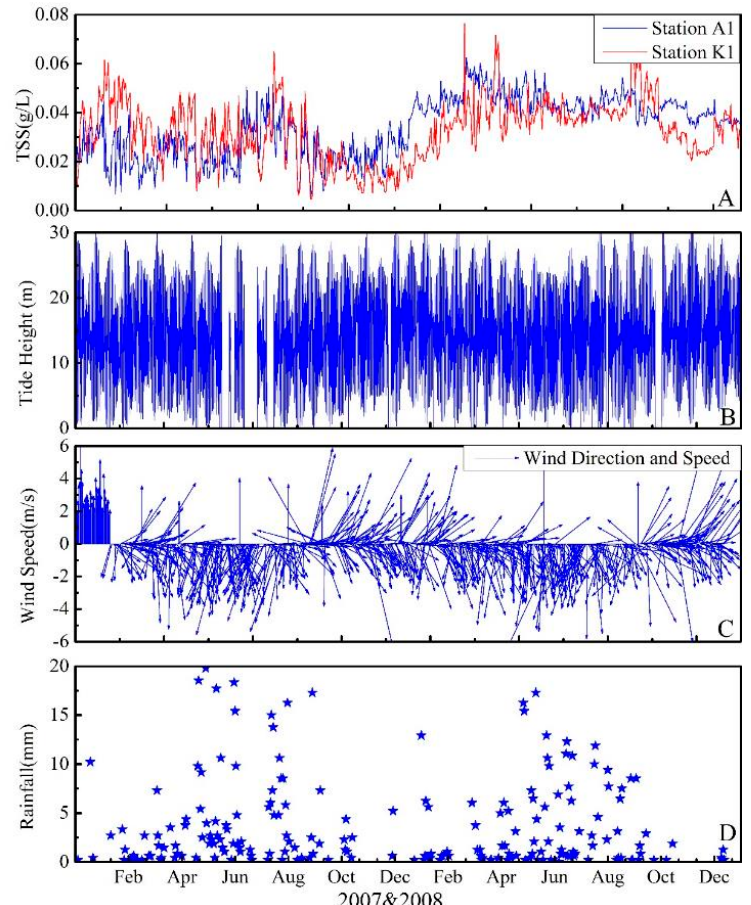
Figure 3. Half-hourly time series of SS (mg/L) at stations A1 and K1 ( A ) with concurrent time series of tide height (m) at Tsim Bei Tsui ( B ), wind speed (m/s) and wind direction ( ° ) at Lau Fau Shan ( C ), and rainfall (mm) at Lau Fau Shan ( D ). The time shown here is local time (Beijing Time), starting from midnight on 1 January 2007 and ending on midnight on 1 December 2008.